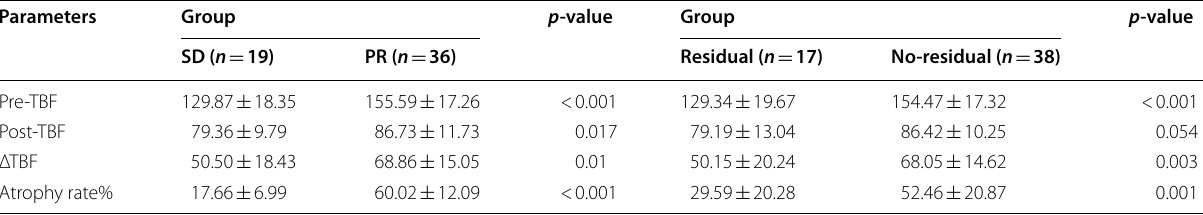
Pre-TBF pre-treatment tumor blood flow; Post-TBF post-treatment tumor blood flow; ΔTBF changes in tumor blood flow; SD the stable disease group; PR the partial response group; TBF in units of mL